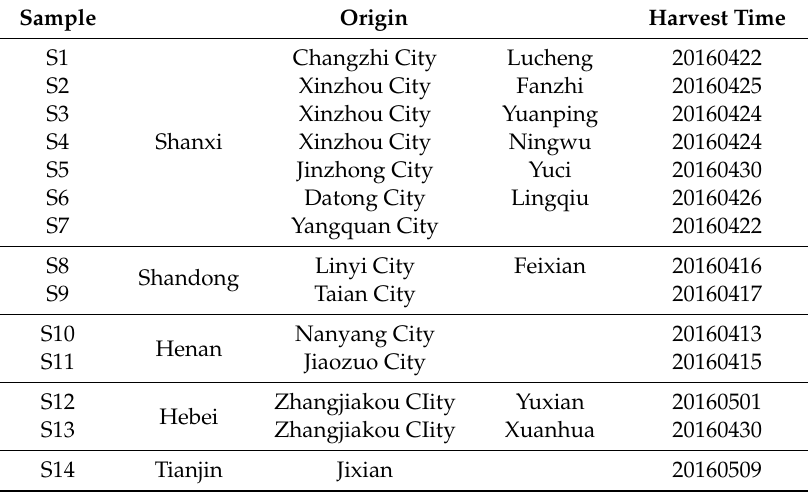
Table 7. Sample information of Cortex